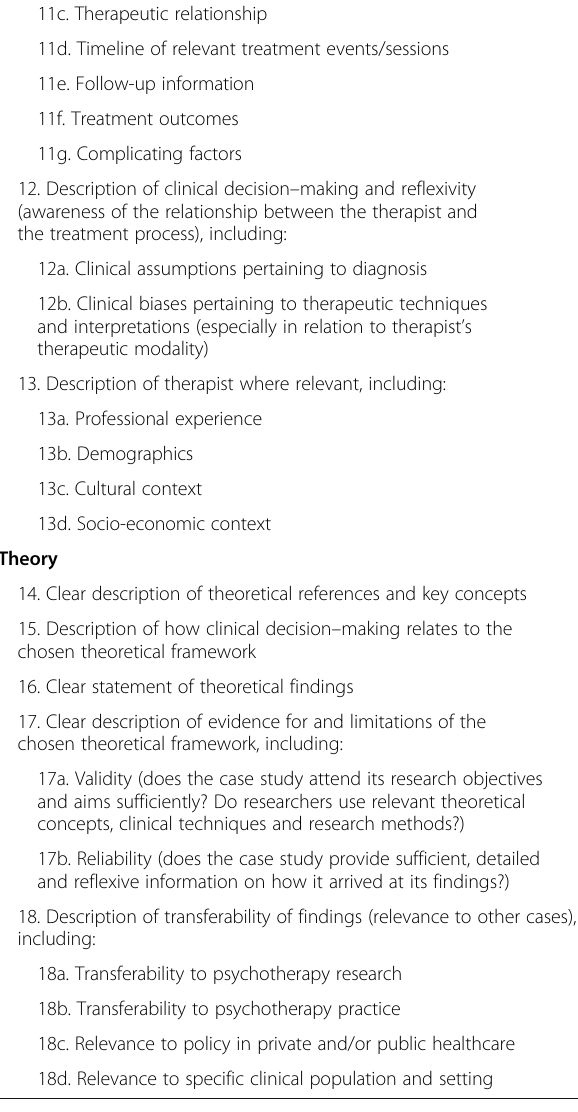
Table 11 Case Study Evaluation-tool (CaSE) checklist for essential components in systematic case studies.